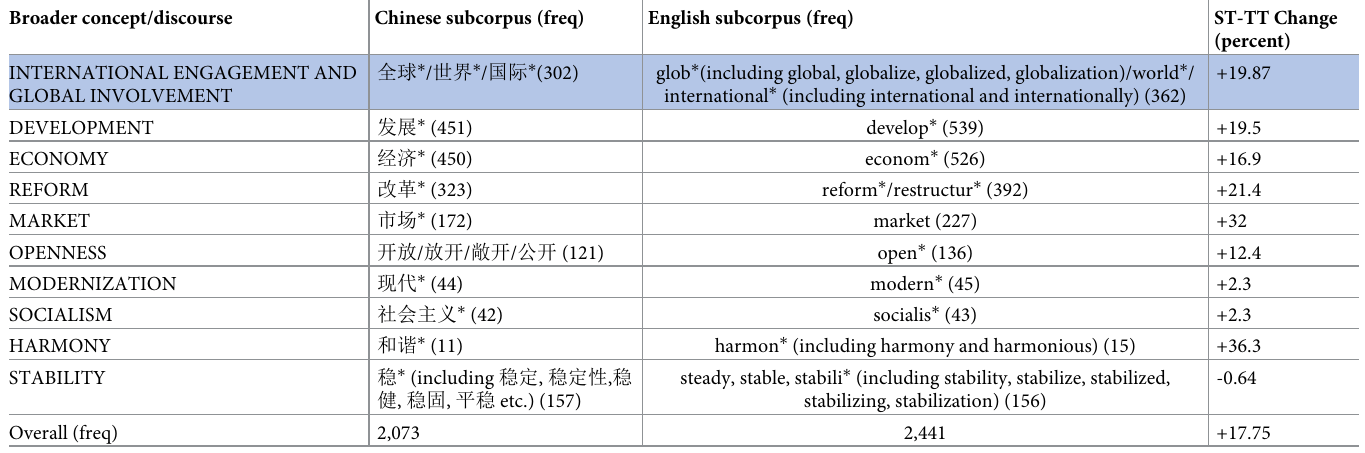
Table 2. Frequencies of items related to ROU at an overall level in Chinese and